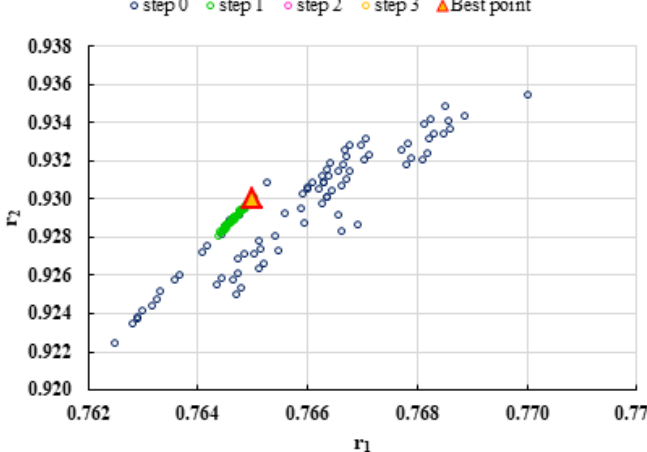
Figure 8. Distribution of P cen ( r 1 , r 2 ) points for each step of searching for the k-NN method for the conditions imposed by HC2.